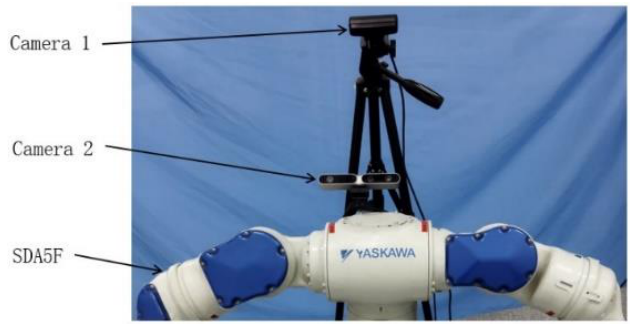
Figure 6. Setup of the two cameras in the dual-arm hand – eye robot system.